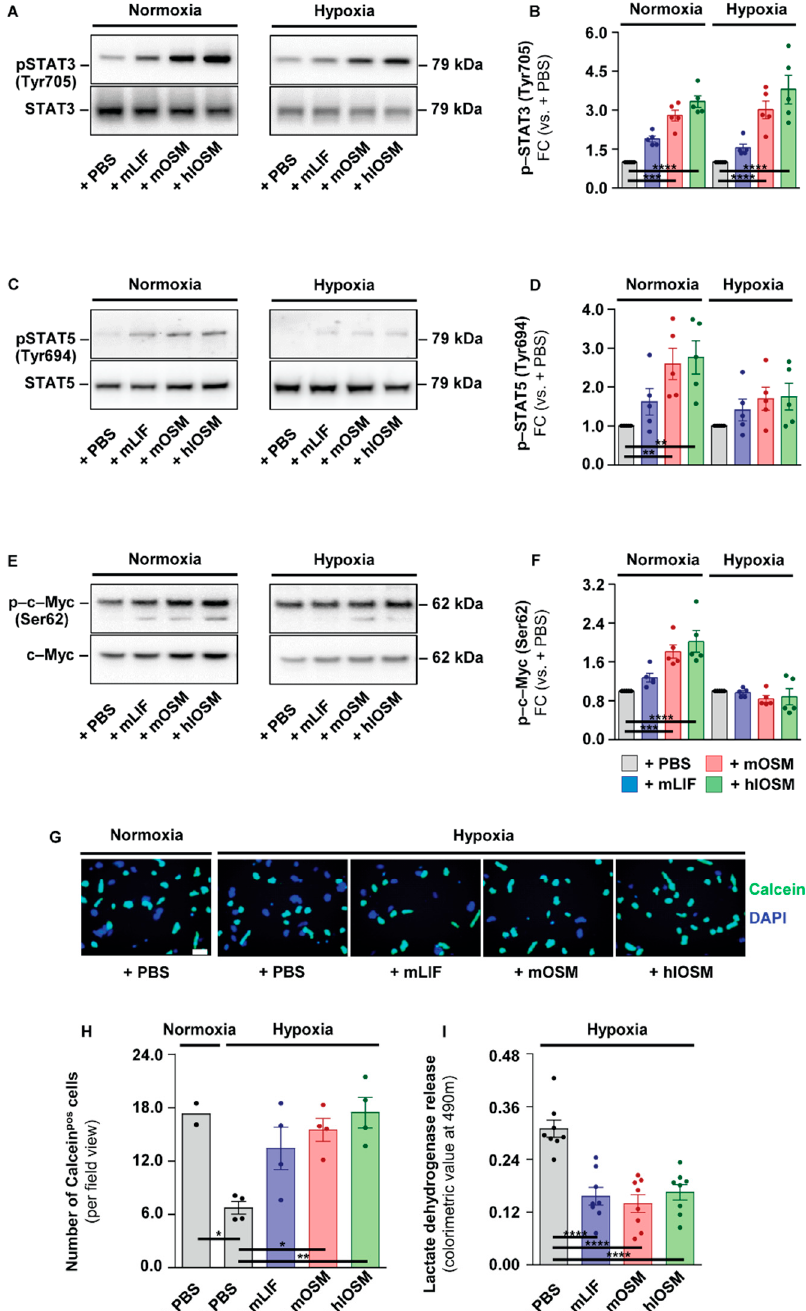
Figure 3 . OSMR- and LIFR-mediated activation of STAT3 but not STAT5 and c–Myc coincides with an increased survival of cultured cardiomyocytes under hypoxic conditions. Representative images and semi-quantitative analysis of immunoblots of ( A , B ) phosphorylated (p–) STAT3 (Tyr705), ( C , D ) p–STAT5 (Tyr694) and ( E , F ) p–c–Myc (Ser62) in cardiomyocytes cultured under normoxic and hypoxic conditions ( n = 5). Statistical analysis was performed by one-way ANOVA together with Bonferroni post-test comparisons to assess differences under normoxic and hypoxic conditions. Asterisks indicate Bonferroni post–hoc test significances between cytokine-treated versus PBS-treated cardiomyocytes with ** p < 0.01, *** p < 0.001 and **** p < 0.0001. Data represent ratios (FC) of expres- sion in cytokine-treated versus PBS-treated cardiomyocytes. Total STAT3, STAT5 and c–Myc ex- pression is shown below. ( G , H ) Representative immunofluorescent images and quantitative analy- sis of Calcein pos viable cardiomyocytes (green) cultured under normoxic and hypoxic conditions (Normoxia +PBS, n = 2; Hypoxia +PBS, +mLIF, +mOSM and +hlOSM, n = 4). Hoechst 33342 (blue) visualizes nuclei of cardiomyocytes. (I) Statistical analysis of lactate dehydrogenase release by hy- poxic cardiomyocytes was performed by one-way ANOVA (n = 8). Asterisks indicate Bonferroni